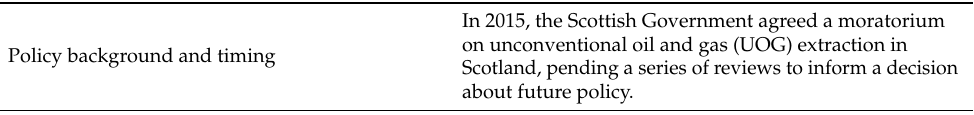
Table 1. HIA of unconventional oil and gas in Scotland